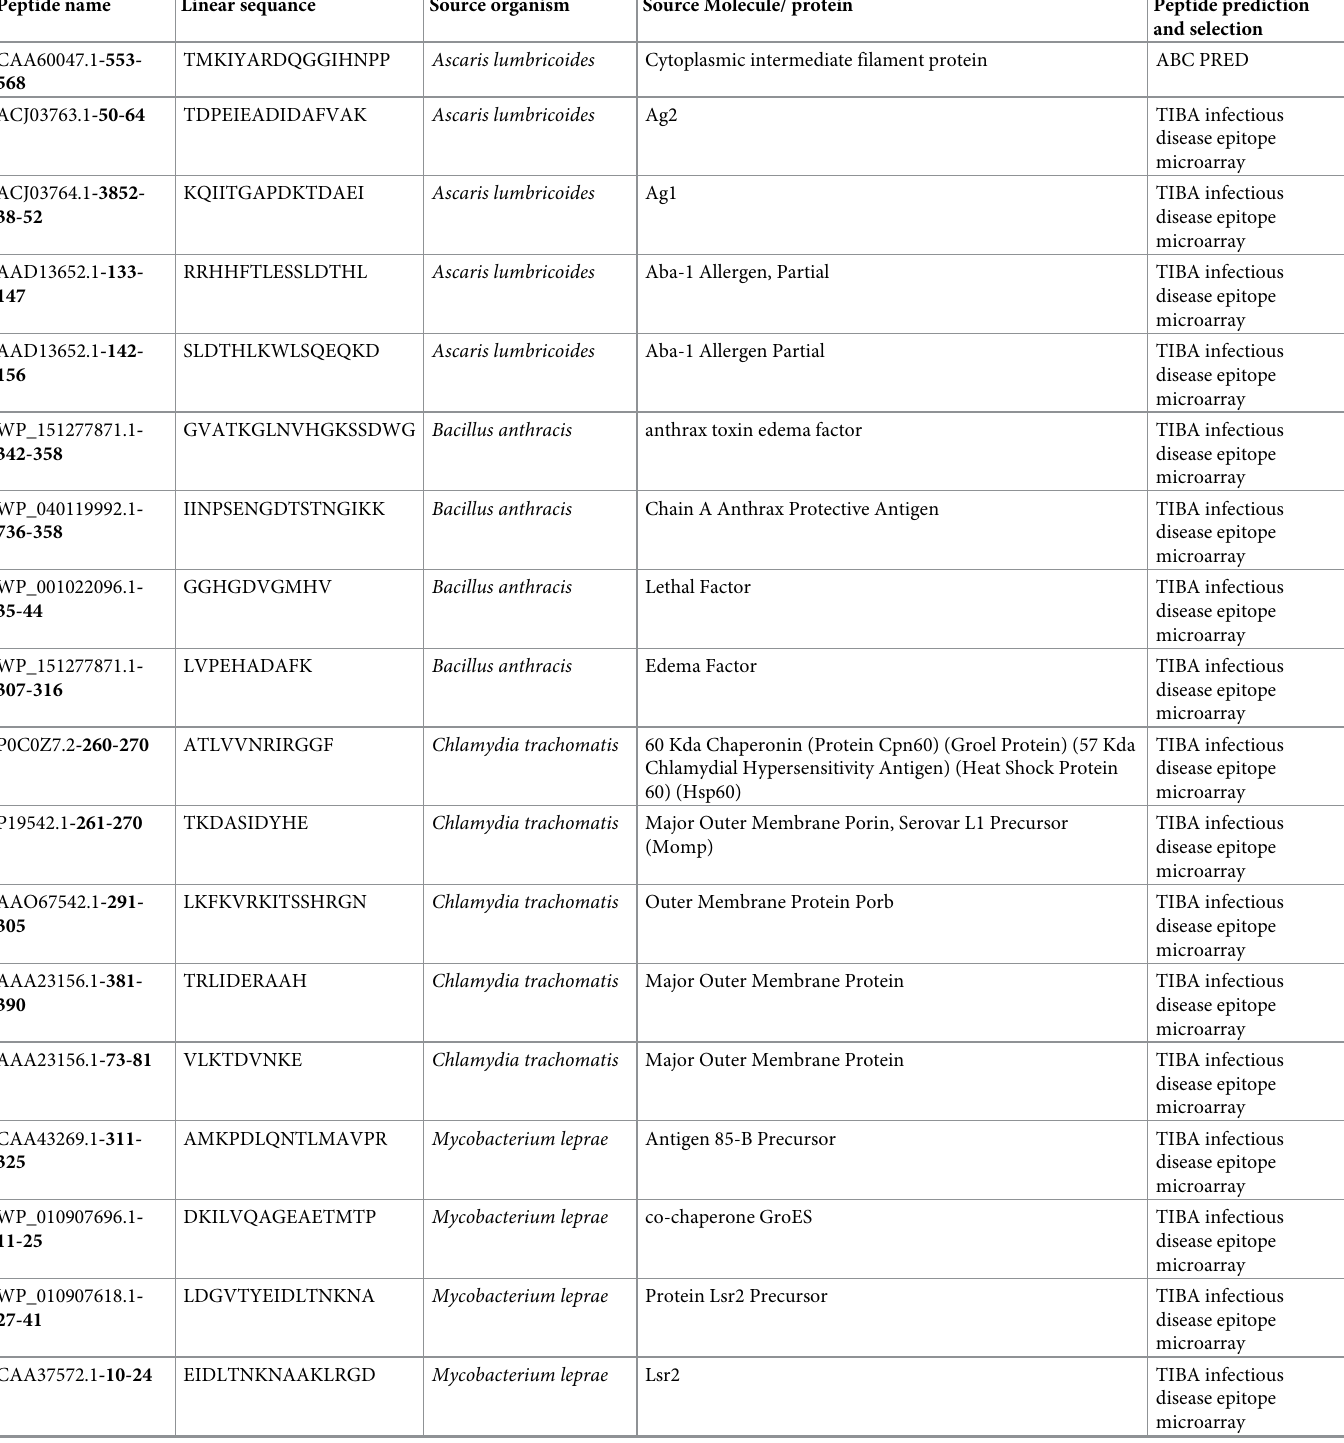
Table 2. TIBA infectious disease epitope microarray and ABCpred selected B-cell epitopes. Peptide